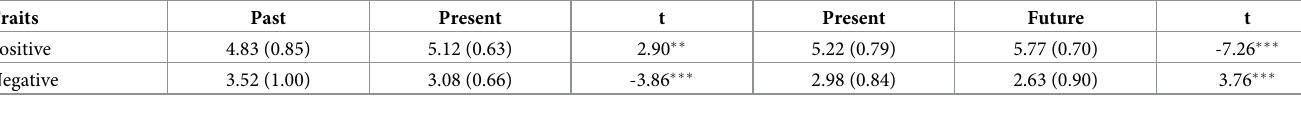
Table 2. Means (and standard deviations) for the past, present and future ratings of the positive and negative TIPI traits with the significance test of the difference between past and presents ratings, and present and future ratings (paired sample t-test).